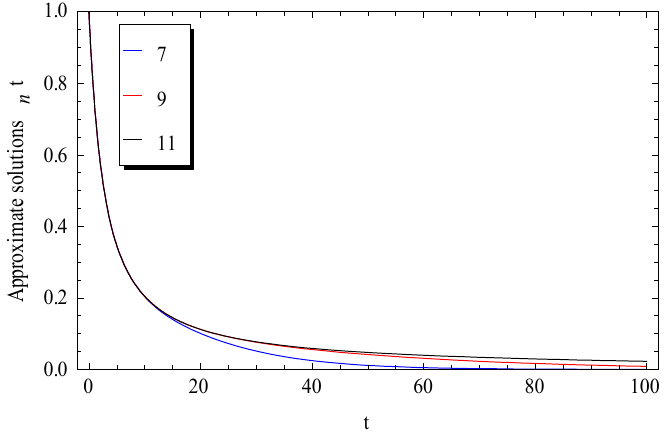
Mathematics 2018 , 6 , x 6 of 11 Figure 1. Convergence of the Adomian approximate solutions at 1 =λ and 5.1 = q . Figure 1. Convergence of the Adomian approximate solutions at λ = 1 and q = 1.5.